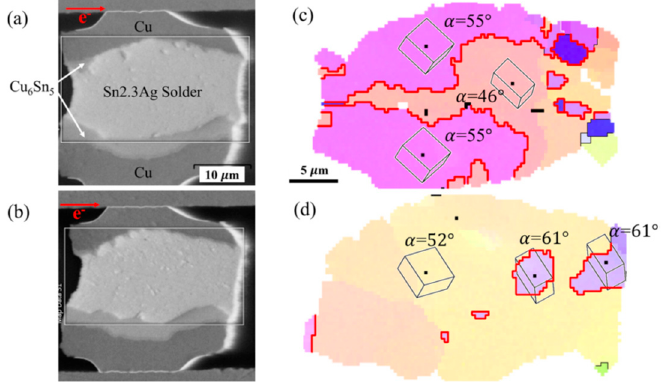
( b ) with upward electron flow. ( c ) Corresponding OIM for the micro-bump in ( a , d ) corresponding OIM for the micro-bump in ( b ). Red arrows represent direction of DC current. Reprinted with per- mission from Ref. [56] Copyright 2017 Elsevier.